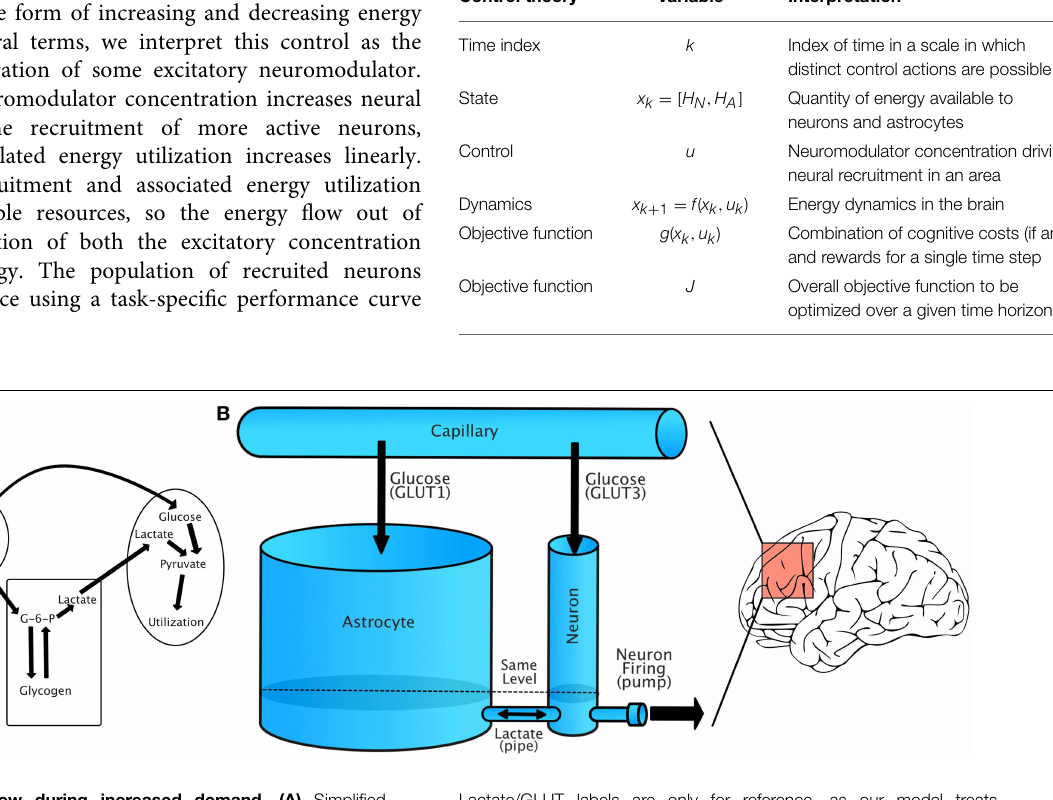
Lactate/GLUT labels are only for reference, as our model treats energy flow as the flow of a single fluid. The model should be understood to represent dynamics in a small region of the brain that has relatively uniform energy